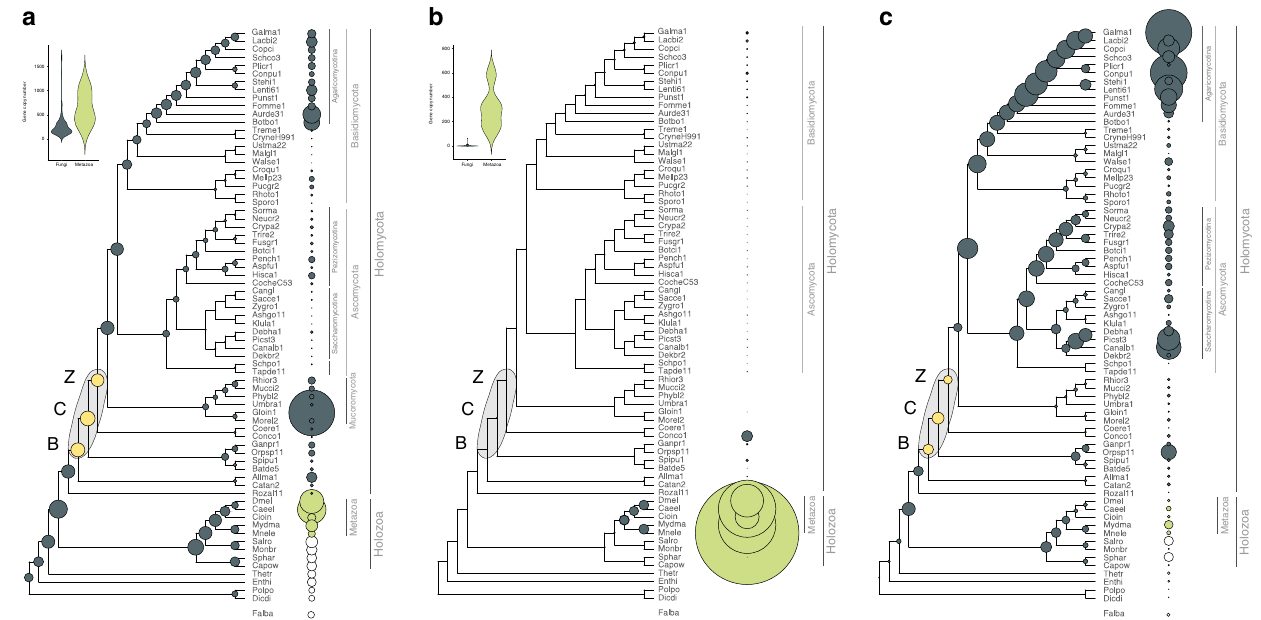
Fig. 2 The evolution of kinases, receptors and adhesive proteins in multicellular fungi. The evolution of Ser/Thr kinases ( a ), canonical GPCRs ( b ) and adhesion-related genes ( c ). BCZ nodes (yellow) represent the putative origin of hyphal MC. Bubble size across the tree is proportional to reconstructed ancestral gene copy number (gray bubbles) and extant gene copy number (at the right side of the tree: gray, green and white bubbles represent fungi, metazoa, and protists respectively). Violin plots for kinases ( a ) and receptors ( b ) show copy number distribution of gene families in multicellular fungi (gray) and metazoans